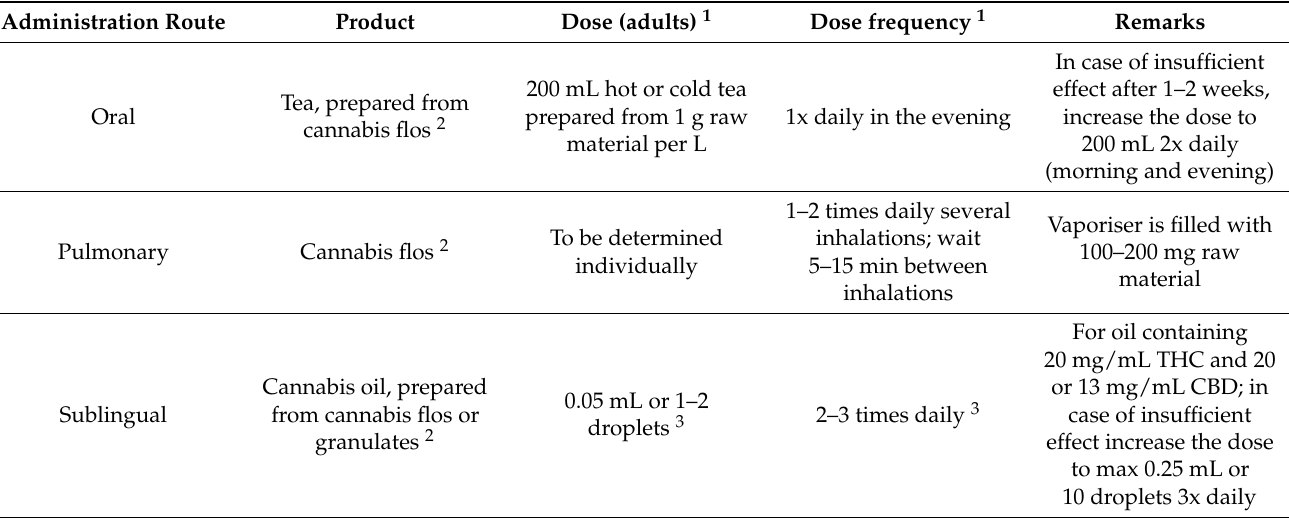
Table 2. Overview of the administration routes for medicinal cannabis products, the recommended dose and dose frequency